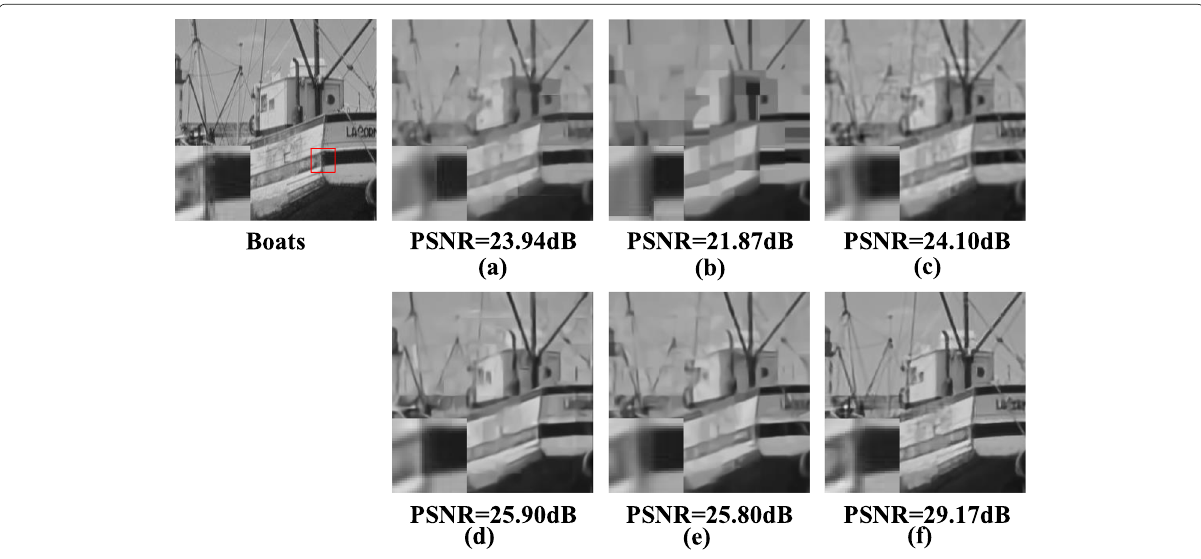
Fig. 12 The reconstruction results of Boats at the measurement rate of 0.1 with BM3D. a TVAL3. b DAMP. c ReconNet. d DR 2 -Net. e CSRNet. f